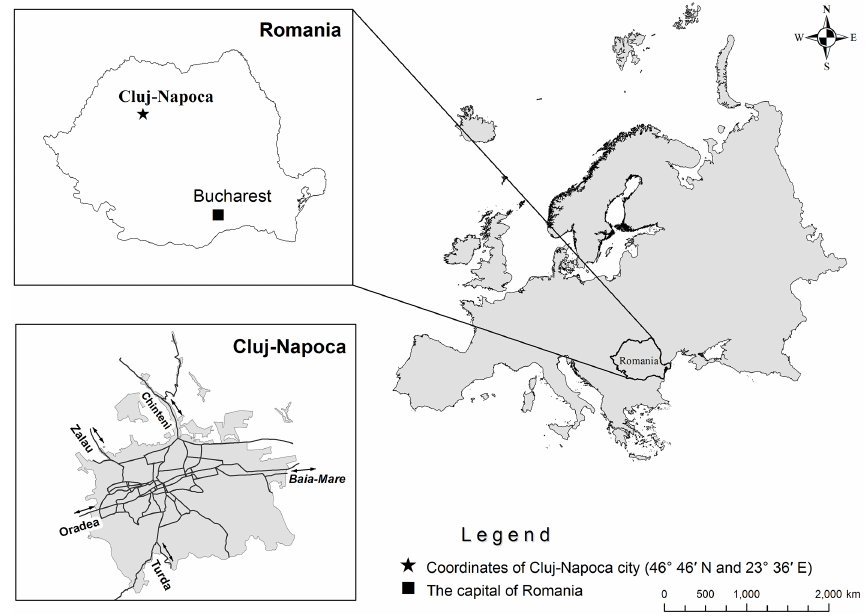
Figure 1. Location of